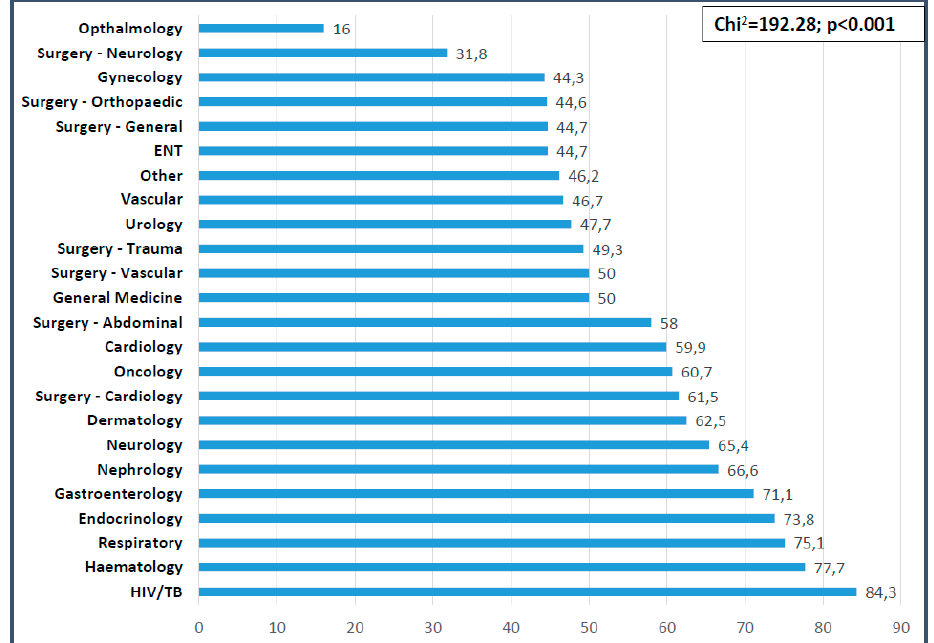
Figure 2. Proportion of patients at risk of malnutrition per diagnostic category at baseline.